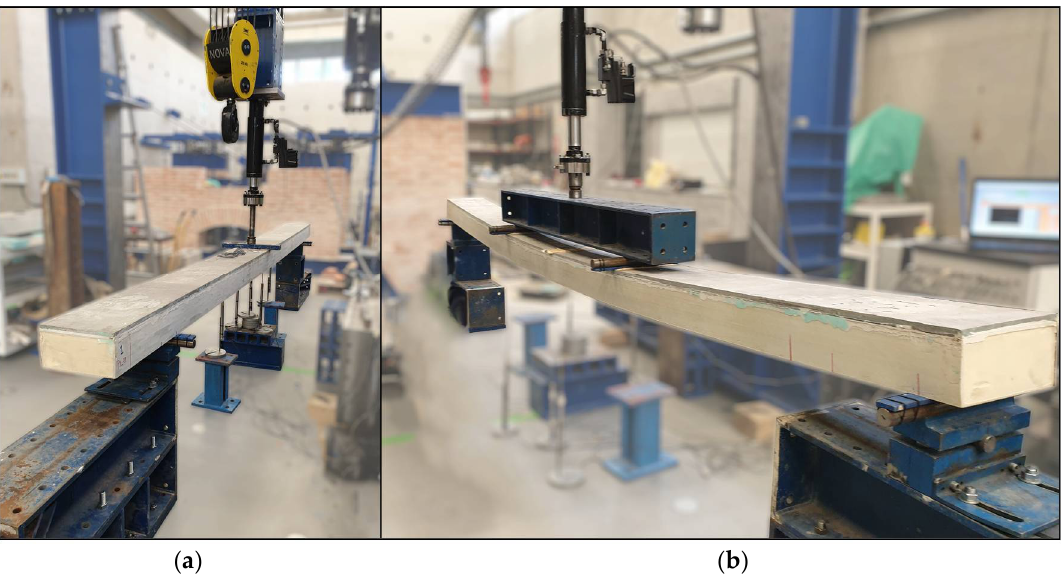
Figure 4. Geometry, test set-up, and instrumentation for the static test with variable span: ( a ) side view and ( b ) cross-section view. Units in mm.